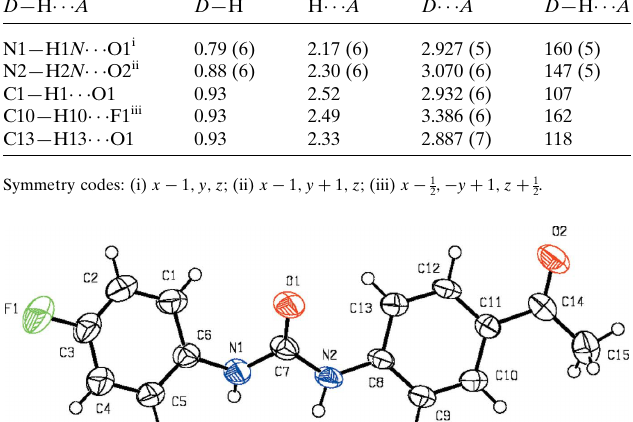
(Table 1). In the crystal (Figs. 2 and 3), N—H (cid:3) (cid:3) (cid:3) O and C— H (cid:3) (cid:3) (cid:3) F hydrogen bonds (Table 1) link the adjacent molecules into layers parallel to (010) forming R 2 motifs. C—H (cid:3) (cid:3) (cid:3) (cid:2) and (cid:2) – (cid:2) interactions are not observed.